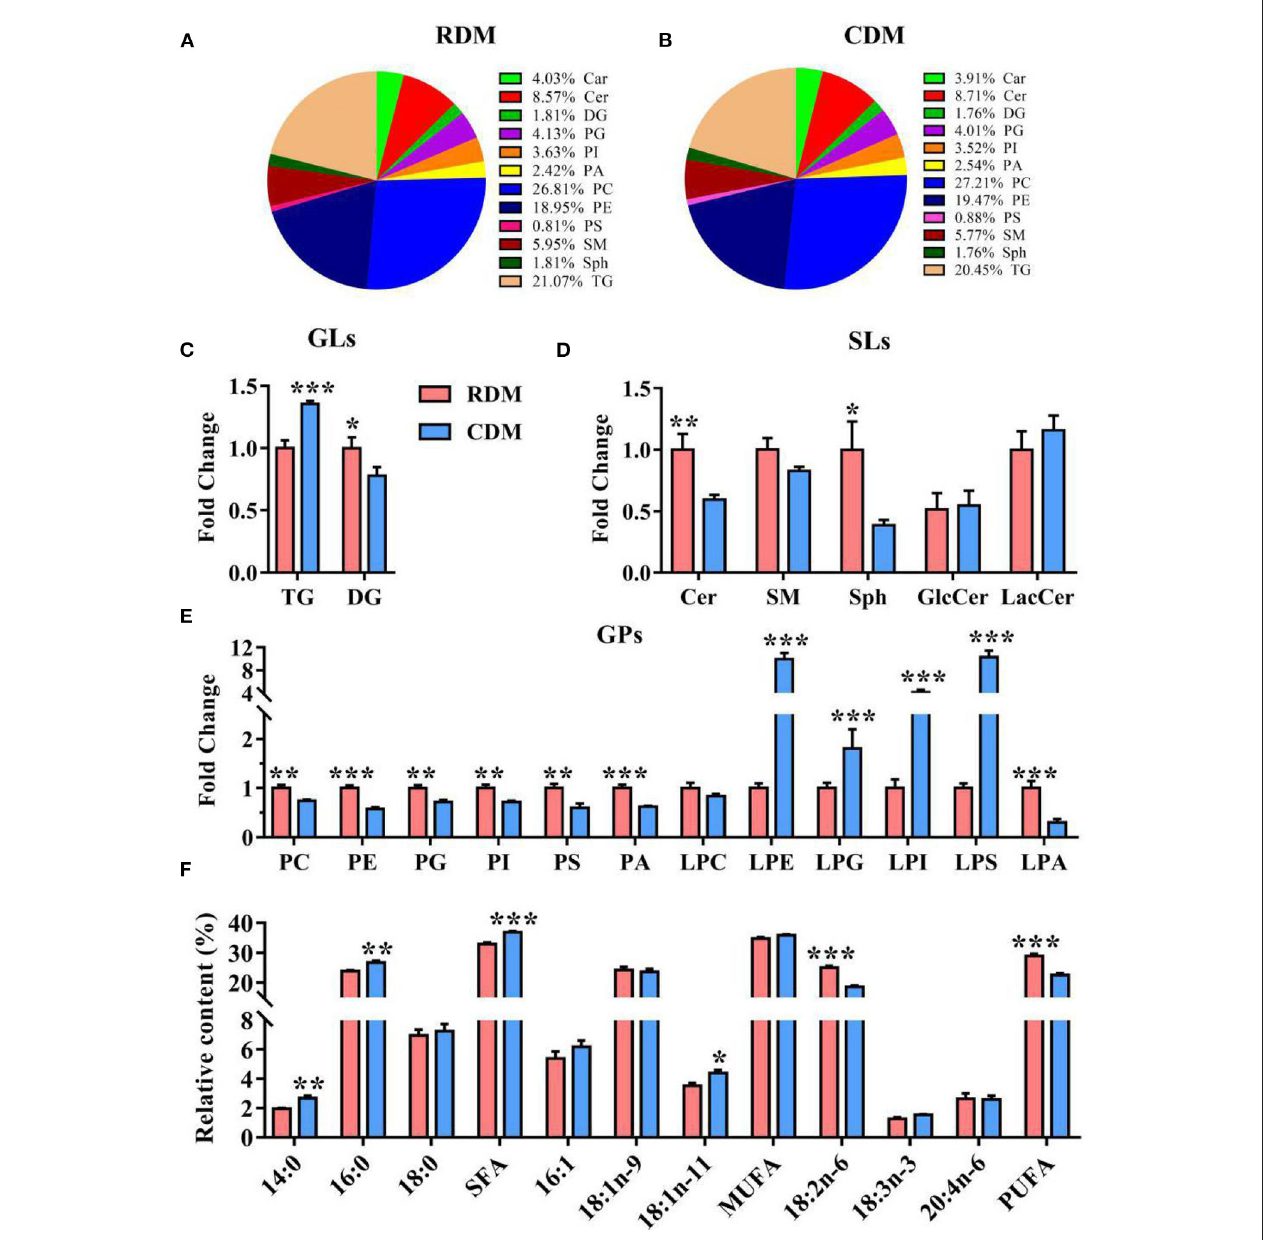
FIGURE 3 | Overall lipid profiles in cooked and raw donkey muscles. (A,B) Percentage of lipid subclasses in RDM (A) and CDM (B) . (C–E) Relative content (% of total lipids) of GLs (C) , SPs (D) and GPs (E) in cooked and raw donkey muscles. (F) Fatty acid profiles in cooked and raw donkey muscles. Data are presented as means ± SEM ( n = 6), * p < 0.05, ** p < 0.01, *** p < 0.001. GLs, Glycerolipids; SLs, Sphingolipids; GPs,